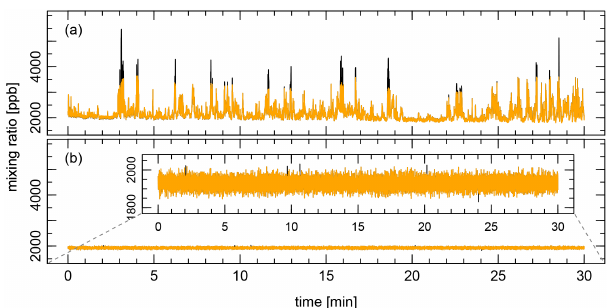
Figure 2. 10Hz time series of CH 4 mixing ratio for two exemplary 30min intervals on 15 June 2013 between 12:30 and 14:30 local time (a) with and (b) without cows in the FP. In black, untreated data; in orange, data after de-spiking. The two cases correspond to the cross-covariance functions in Fig. 3a and b.